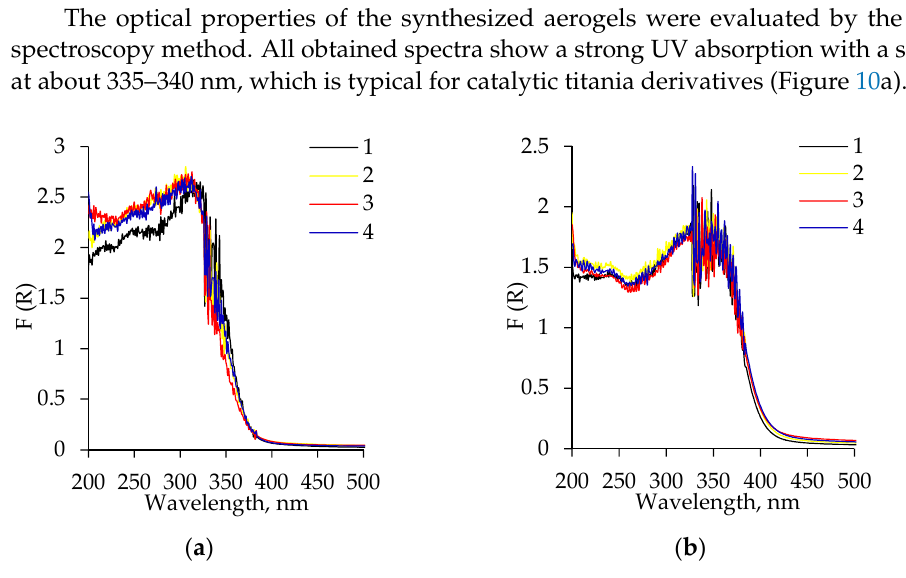
calcination. 1–2 correspond to the precursor TIP and 3–4—to TBOT: 1, 3—without solvent exchange;